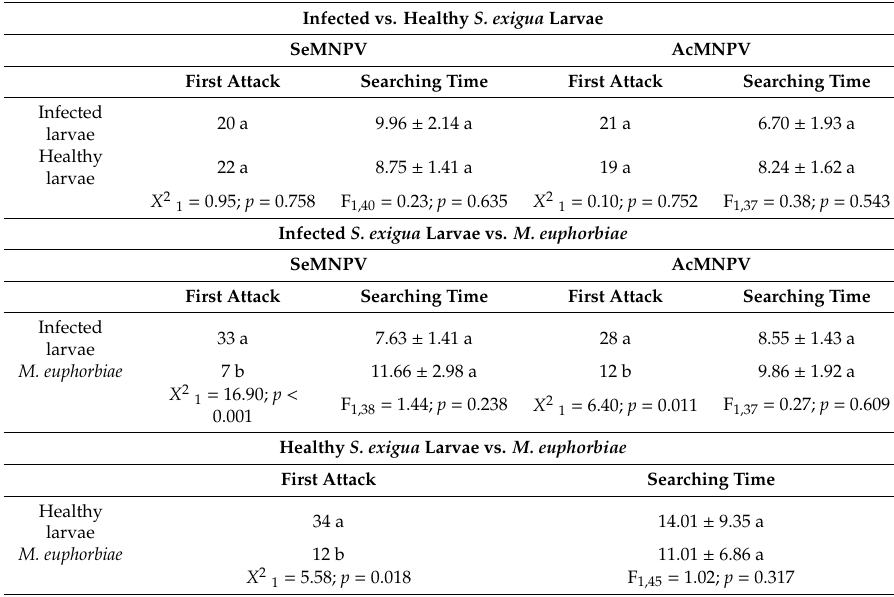
Table 5. Assessment of prey preference habits of Chrysoperla carnea L 3 larvae under di ff erent choice scenarios: infected vs. healthy S. exigua larvae, infected S. exigua larvae vs. M. euphorbiae , and healthy S. exigua larvae vs. M. euphorbiae